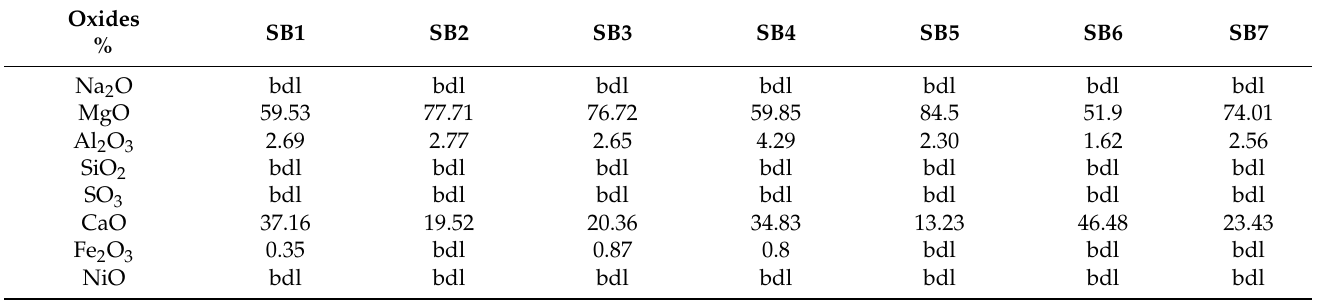
Figure 2. Microphotographs of subspherical elements in an air hardening magnesian lime coming from a bedding mortar of a small bridge located in a rural area of the Sainte Baume massif in Provence (18th century) ( a ) under PLM, xpl, ( b ) SEM EDS map of Ca, and ( c ) SEM EDS map of Mg. Table 2. Microchemical spot analyses (SB1-SB7) of subspherical elements in the binder of Figure 2.